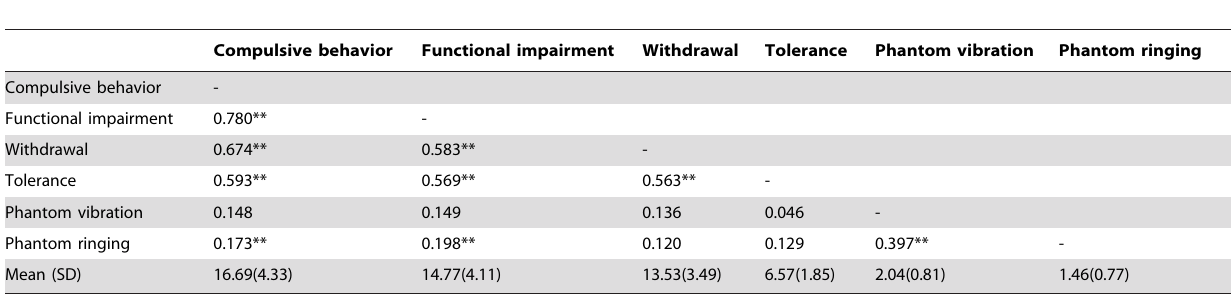
Table 2. Correlations, means, and standard deviations for the subscales of Smartphone Addiction Inventory (SPAI) and phantom vibration/ringing